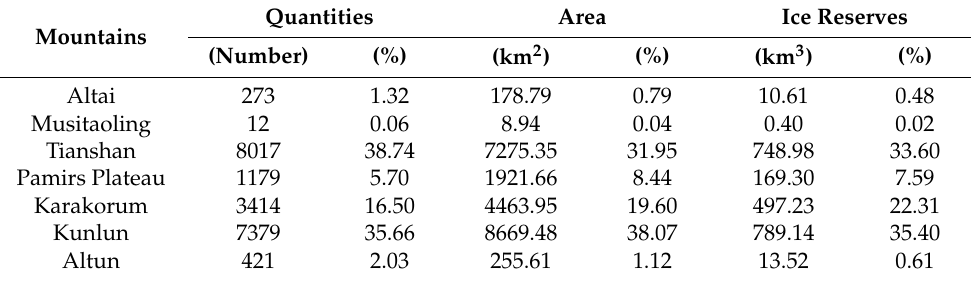
Table 2. The glacier resources in different mountains in Xinjiang.